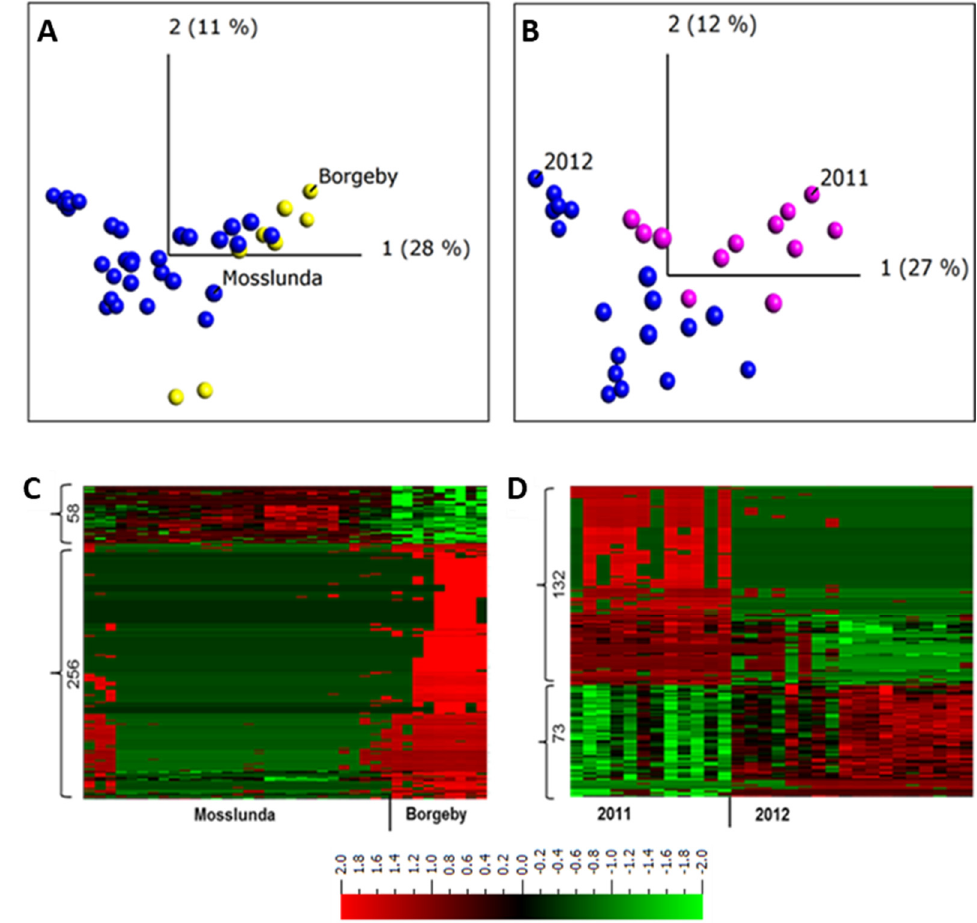
Figure 2. Principal components and heat map analyses of apoplastic proteome samples isolated from potato cultivar Bintje grown at two experimental sites (Borgeby and Mosslunda) and in two different growing seasons (2011 and 2012) in Mosslunda. ( A ) Unsupervised principal component analysis plot of the samples in Mosslunda and Borgeby; ( B ) Unsupervised principal component analysis plot of the samples in Mosslunda in 2011 and 2012; ( C ) Abundance of peptides from Borgeby respectively compared to those in Mosslunda; ( D ) Abundance of peptides collected in 2011 respectively compared to those collected in 2012 in Mosslunda. Two-group comparisons ( t -test) were performed in Qlucore with false discovery rate using Benjamini − Hochberg correction ( q < 0.001). Heat maps are sorted using hierarchal clustering and red represents higher abundance (Fold change, log2).